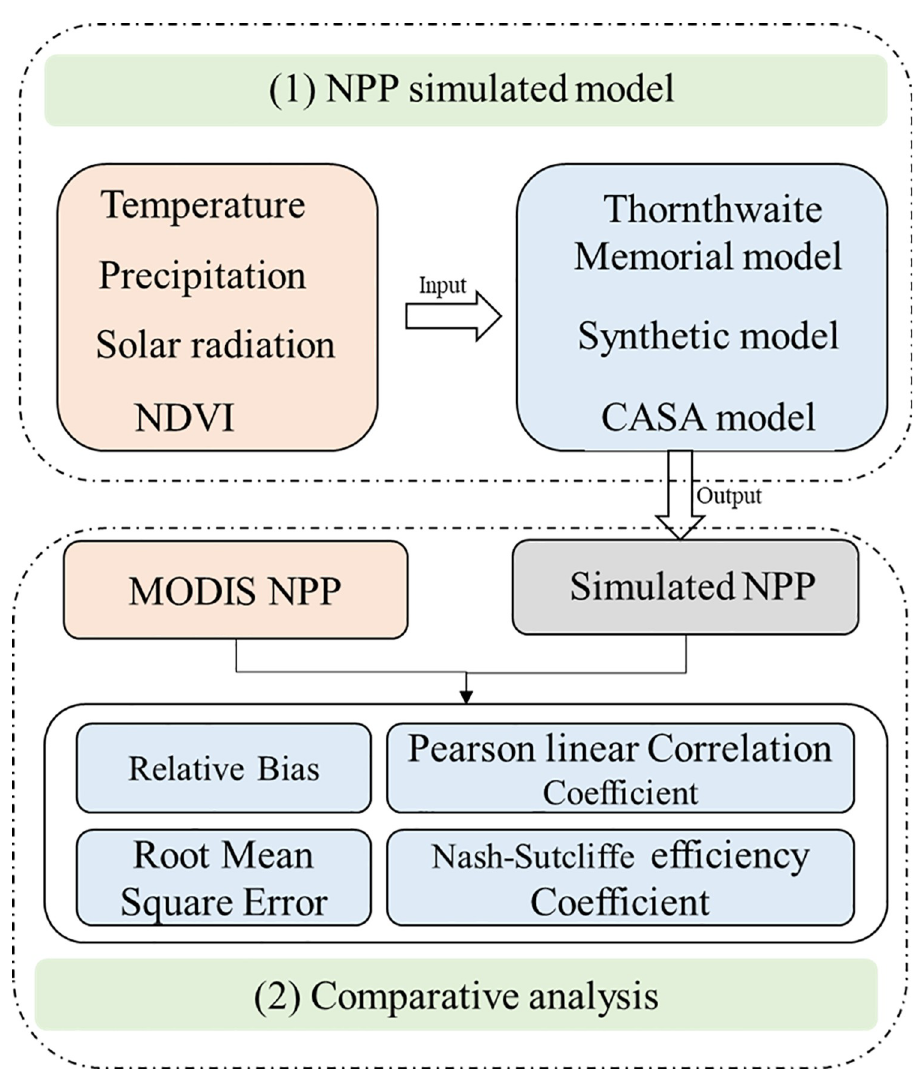
Fig 3. Flowchart of the methodology employed in this study. Light green represents the process of this study; Light orange represents data used in this study; Gray represents the output; Light blue represents the methods.